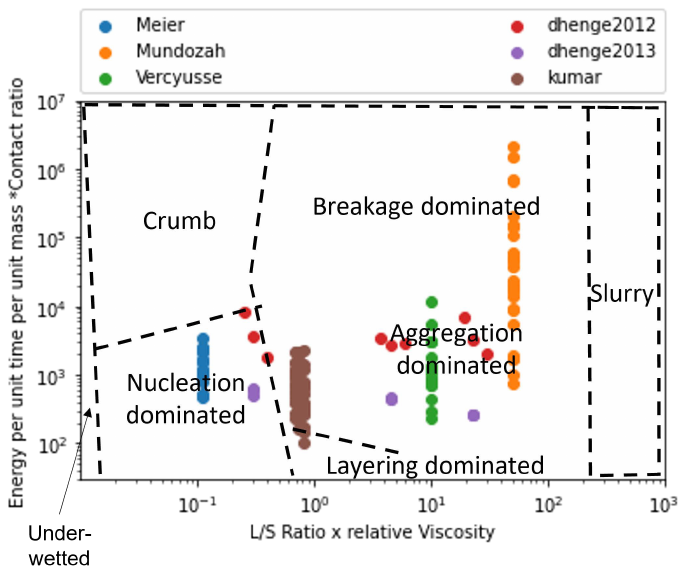
Figure 7. The regime map developed with proposed boundaries and each point colored according to the experimental study used in development. The regimes described by the boundaries in this map can explain the experimentally observed regimes with good accuracy